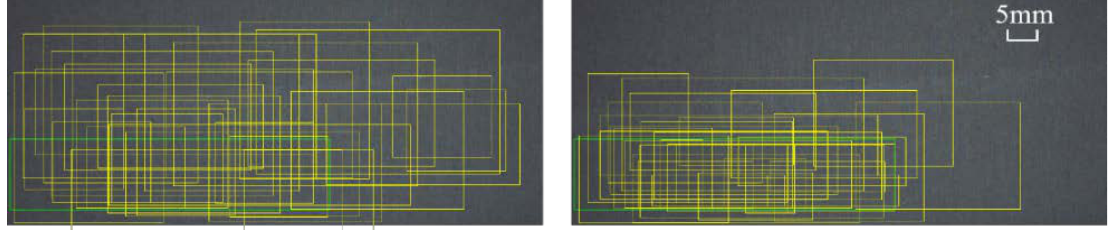
Figure 12. Sample RPN proposals from Faster R-CNN and C-G RPN.